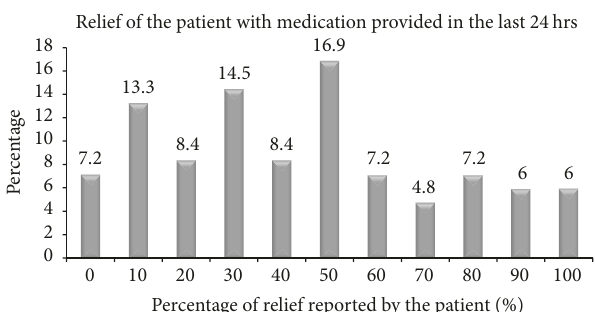
Figure 1: Percentage of pain relief with medications provided in the